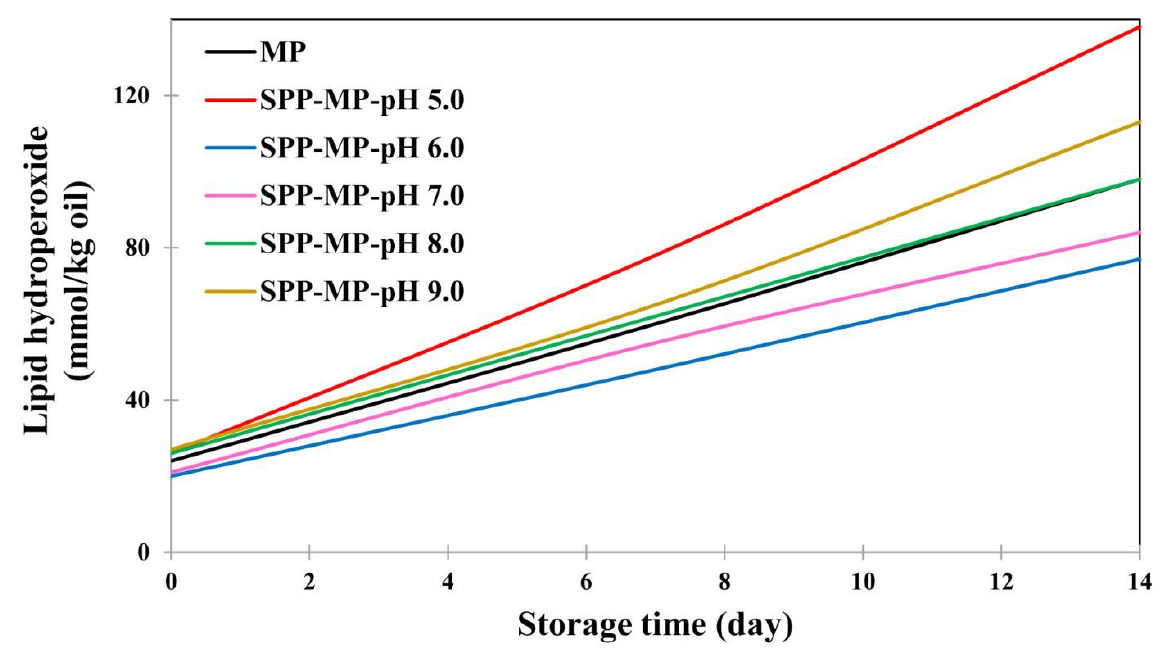
Figure 3. Changes in lipid hydroperoxides of sodium pyrophosphate (SPP) — modified myofibrillar protein (MP) emulsion gels under different pH conditions during 14 days of storage at 25 °C (adopted from Ref. [78]).